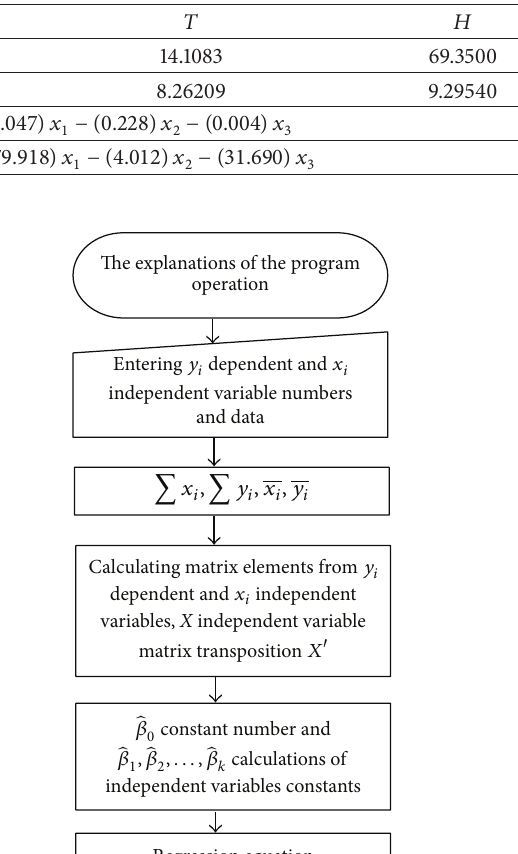
Table 3: Descriptive statistics, 𝑅 2 , and regression equations from SPSS software.